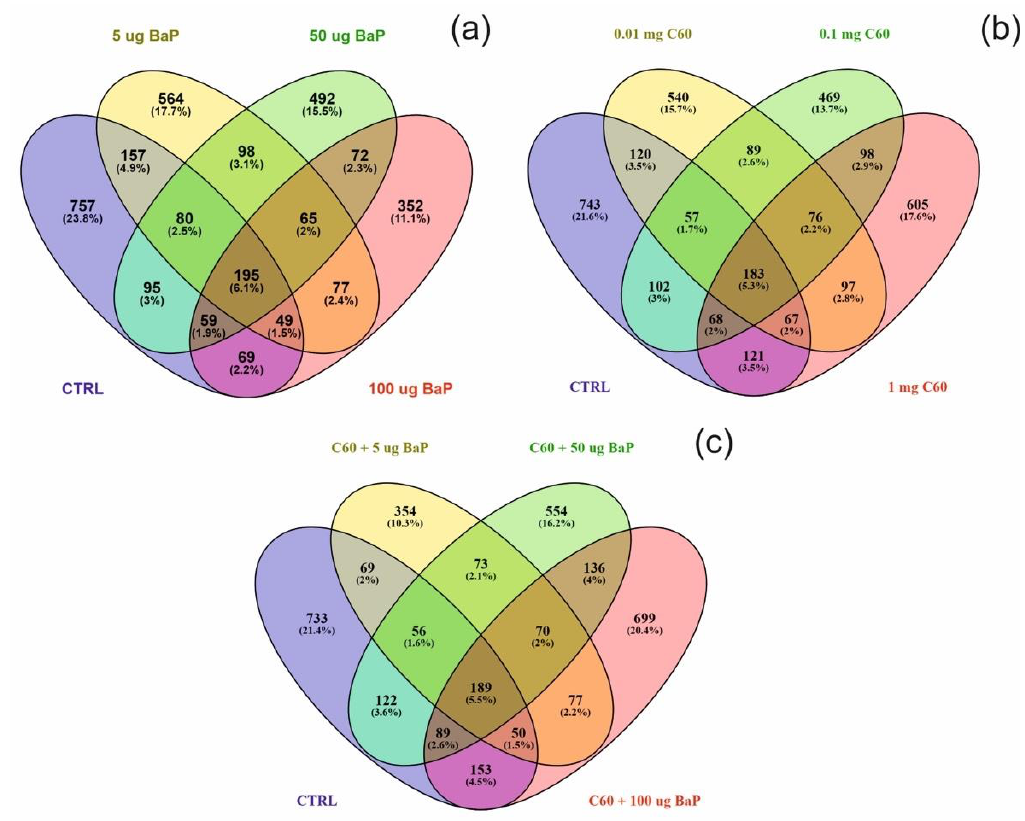
Figure 5. Venn diagram visualising the overlap between the control sample and varying concentrations of B[a]P ( a ), C 60 ( b ) or a mixture of the two (5–50–100 µg/L B[a]P 1 mg/L C 60 ) ( c ) following exposure for three days. Note that overlap is based on a threshold of p < 0.05 and does not include FDR correction.